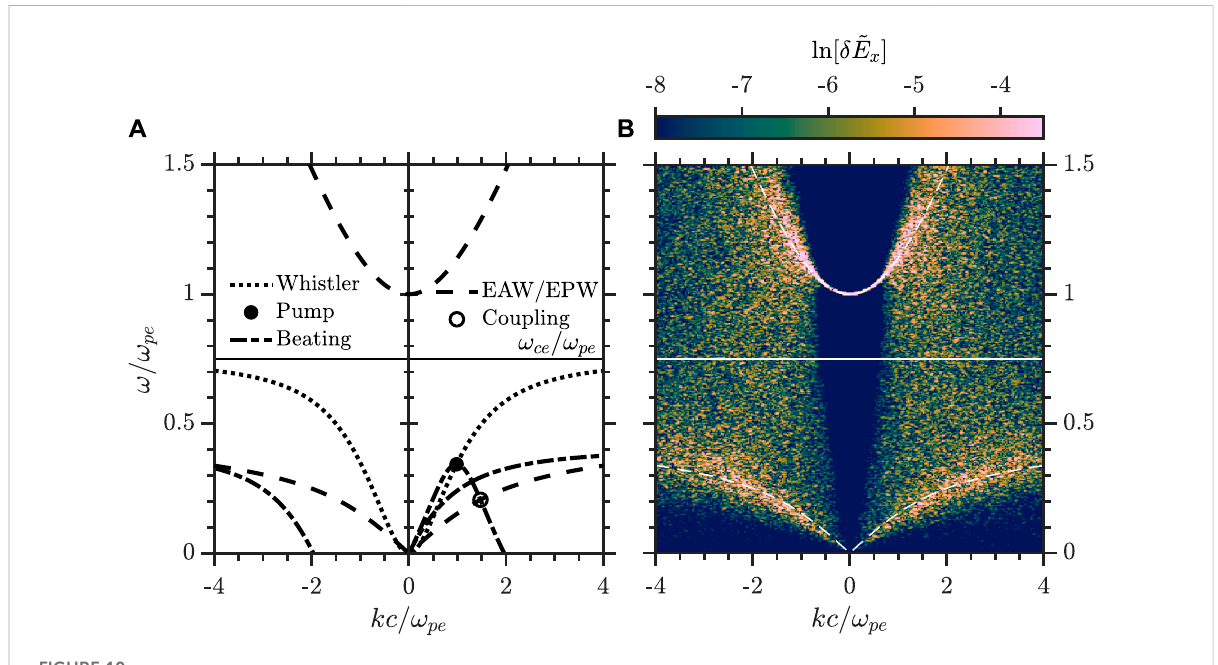
Ponderomotive coupling between whistler waves and electron acoustic waves (EAW). (A) In the same format as Figure 1, the pondermotive beating of the pump whistler wave and whistler branch can couple to the electron acoustic wave of a two-electron-species plasma (B) Demonstration of the electron acoustic mode in the UPIC simulation using T h / T c =100, vth =3.16 ( v tc =0.316), n h =0.9 n e ( n c =0.1 n e ), and ω ce / ω pe